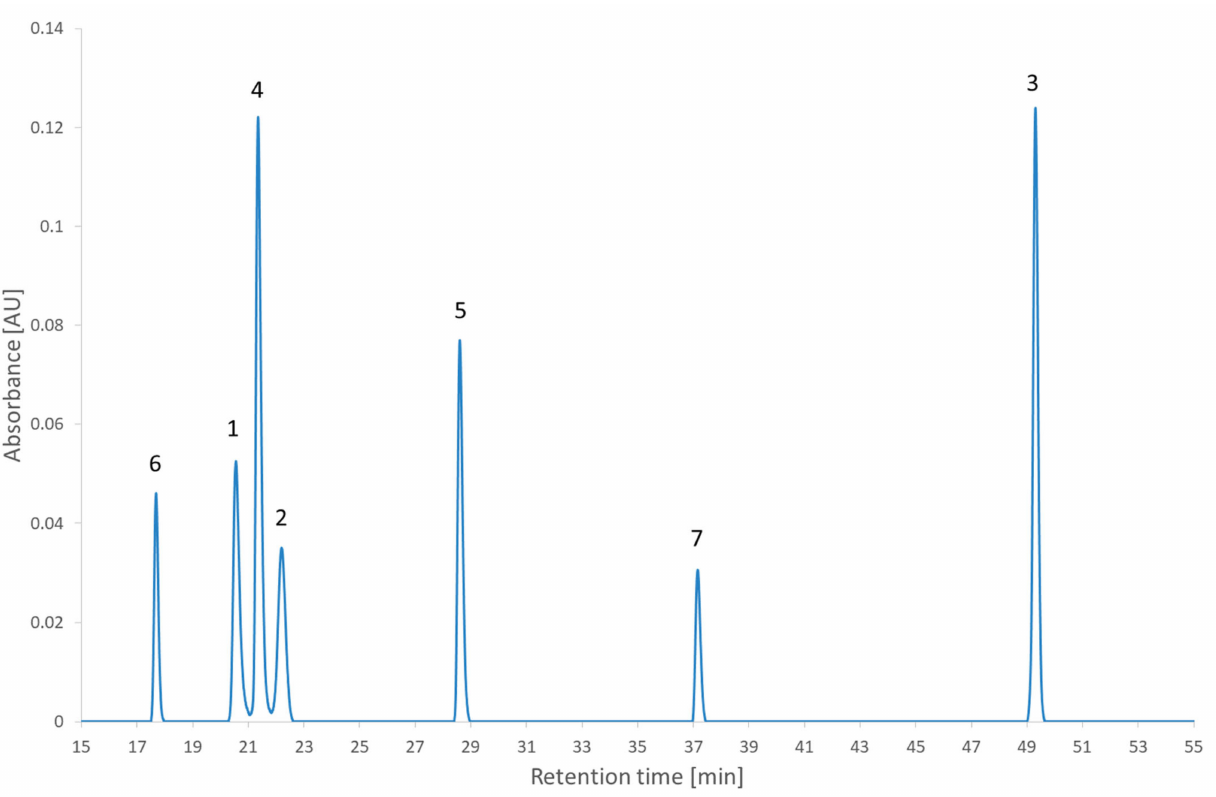
Figure 9. The chromatogram extracted at 210 nm of the second test set analyzed in the condition of pH 4.2 and a gradient time of 60 min. 1: 2,2 (cid:48) -bipyridine, 2: 4-nitrophenol, 3: ibuprofen, 4: metoclopramide, 5: papaverine, 6: pindolol, 7: